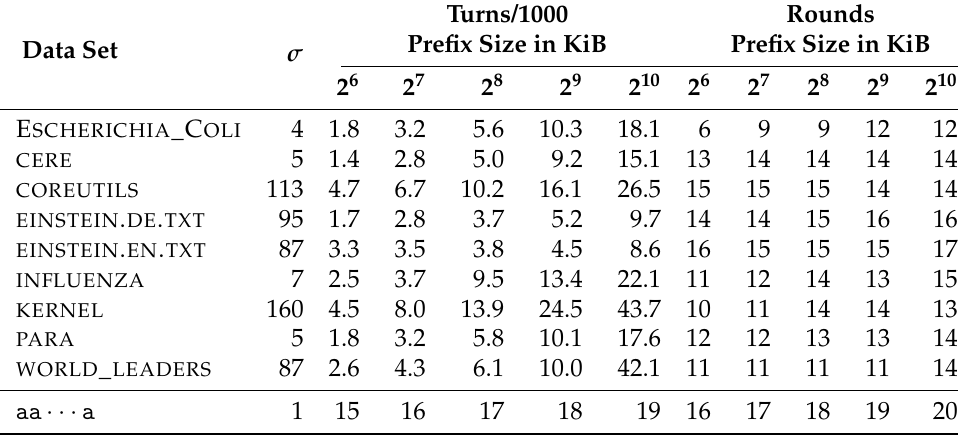
Table 3. Characteristics of our data sets used in Section 2.6. The number of turns and rounds are given for each of the prefix sizes 128, 256, 512, and 1024 KiB of the respective data sets. The number of turns reflecting the number of non-terminals is given in units of thousands. The turns of the unary string aa · · · a are in plain units (not divided by thousand).